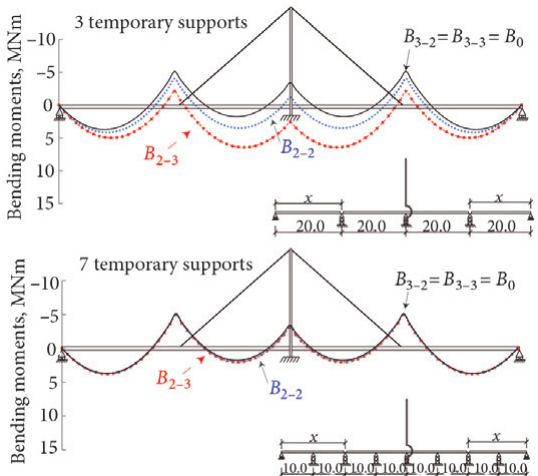
Fig. 5. Bending moment diagrams in the deck of structures B 2–2 , B 2–3 , B 3–2 , B 3–3 and B 0 built with two 20 m long